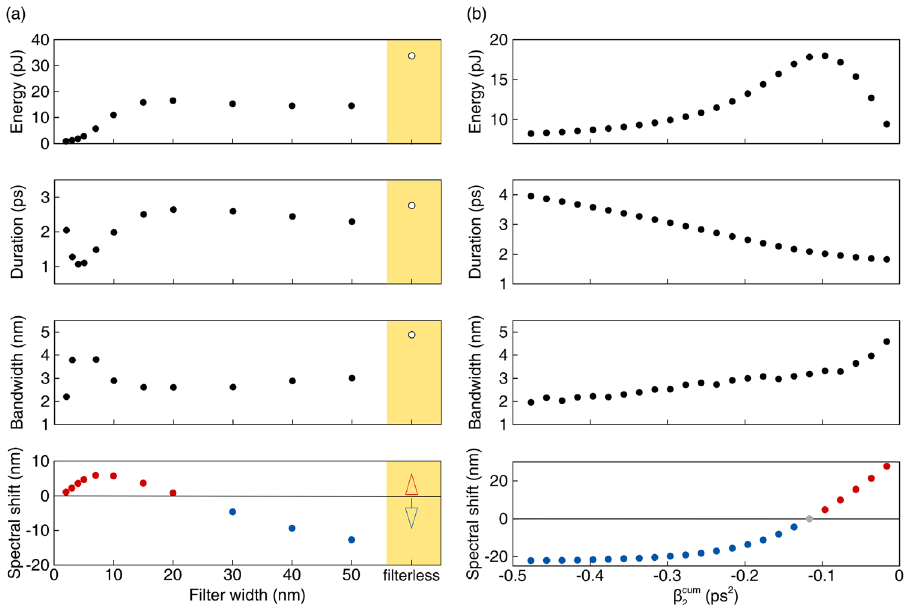
Figure 6. Dependence of energy, duration, bandwidth and spectral shift of the intracavity pulse on: ( a ) the filter cum 0.18 ps 2 ); and on ( b ) the cumulative dispersion (filter bandwidth bandwidth (the cavity dispersion is β 2 = − is 45 nm). Empty circles correspond to the laser cavity without filter.